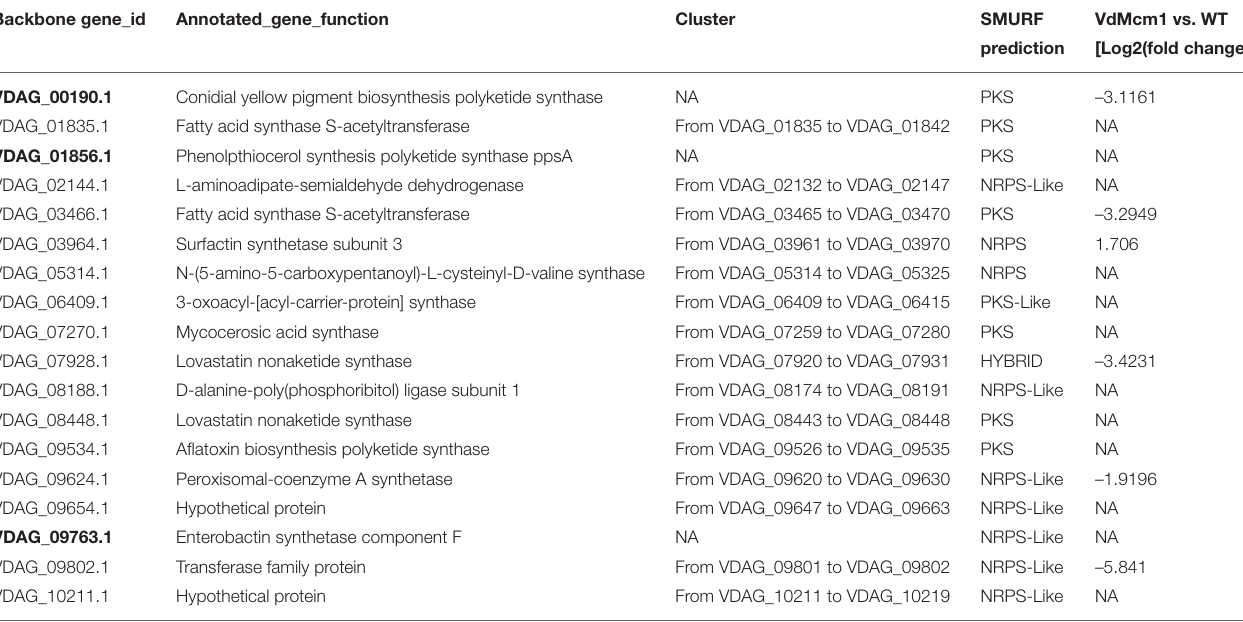
TABLE 2 | Putative secondary metabolism gene clusters and their expression in V. dahlia. Backbone